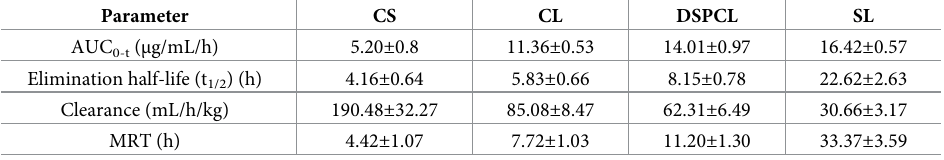
Table 5. Pharmacokinetic parameters of free CLB solution (CS), conventional liposomes (CL), DSPC liposomes (DSPCL) and stealth liposomes (SL) in arthritic rats (dose 1 mg/kg).